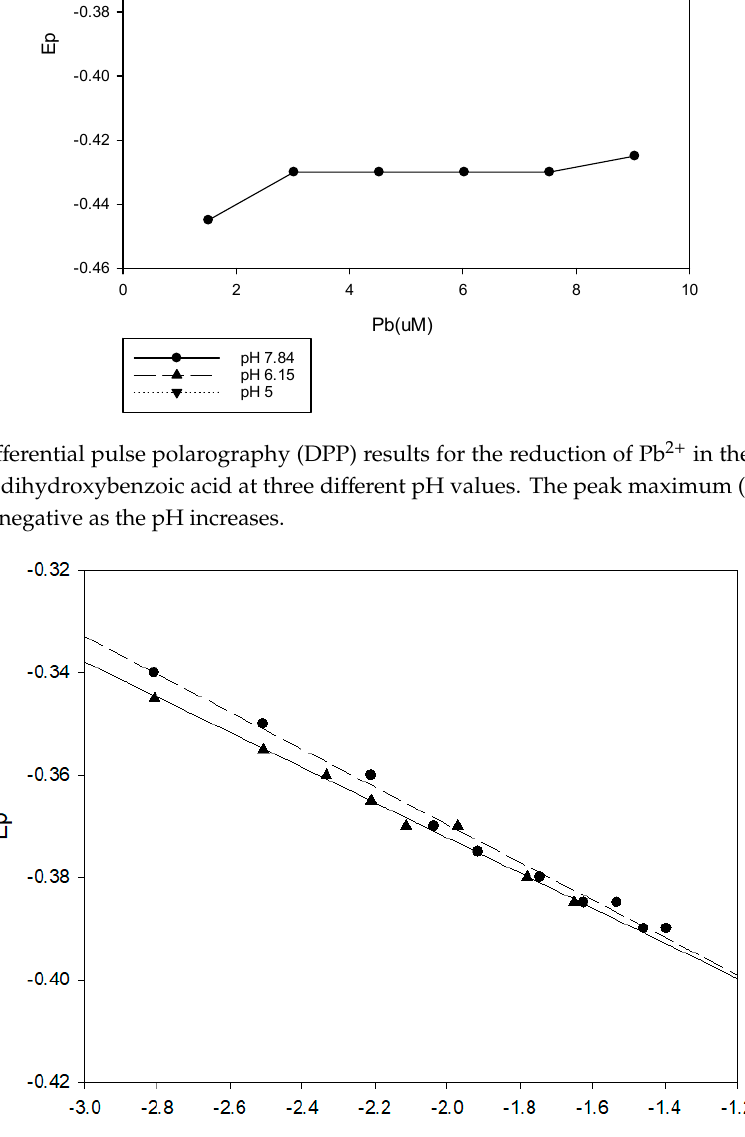
Figure 2. DPP results for Pb 2+ in the presence of a range of salicylic acid concentrations. There was little difference in the results for pH 6.15 and pH 7.85. The linear relationship between E p and log (salicylic acid) is consistent with the Lingane equation.